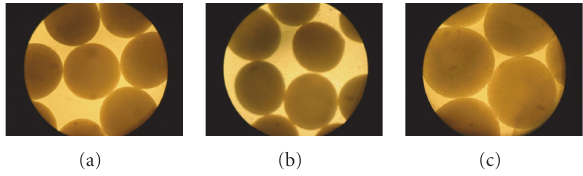
Figure 5: Evaluation of microcapsule integrity and morphological changes during simulated GI transit. (a) Pre-stomach transit. (b) Post-stomach transit (60 minutes). (c) Post-stomach (60 minutes) and intestinal (10-hour) transit. Microcapsule size (a) 608 ± 36 μ m (b) 544 ± 40 μ m (c) 725 ± 55 μ m.